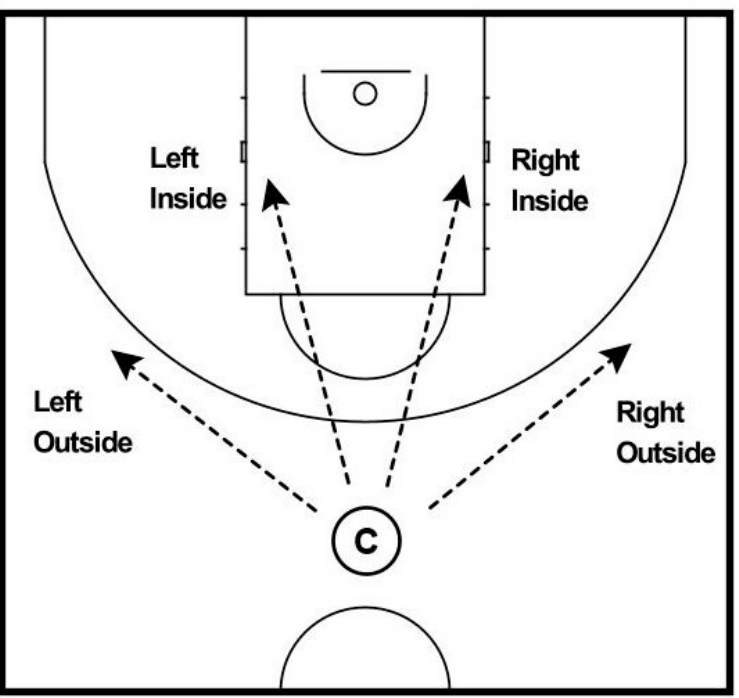
Figure 2. Passing options in the decision-making assessment. Note. Camera